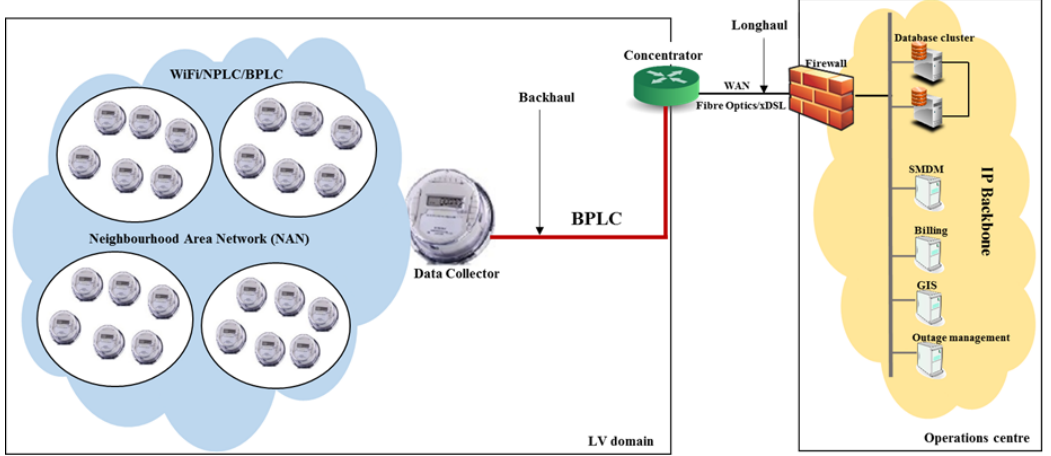
Figure 1. Logical topology of smart metering network over the low voltage (LV) power line network.